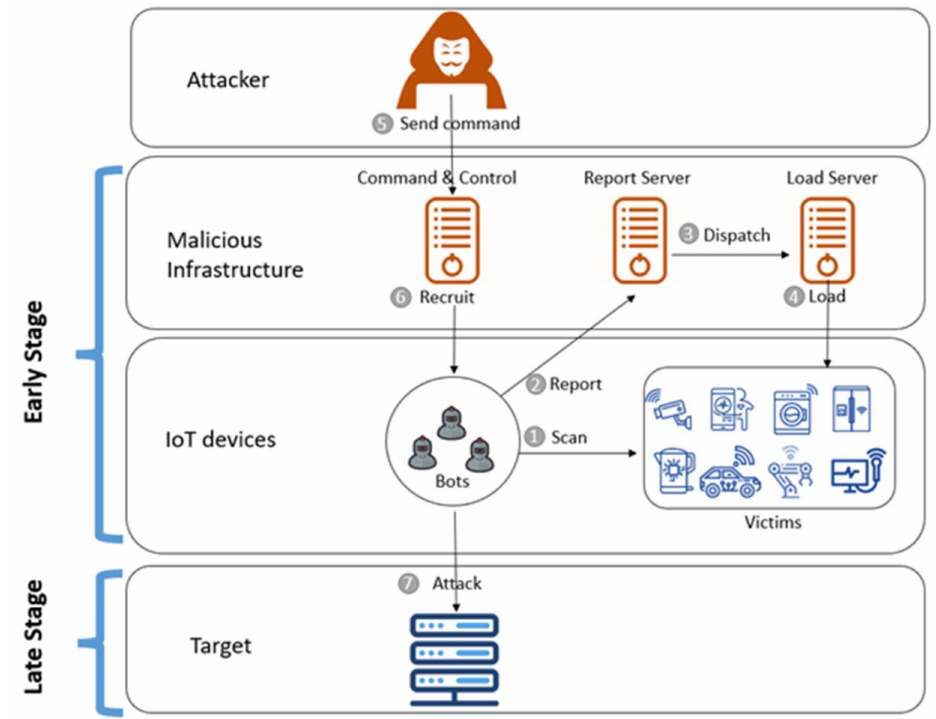
Figure 1. The IoT botnet formation stages